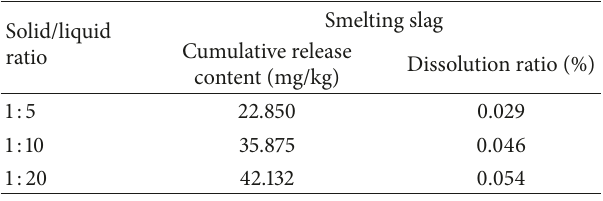
Table 1: Accumulation release concentration and dissolution rate of smelting slag.